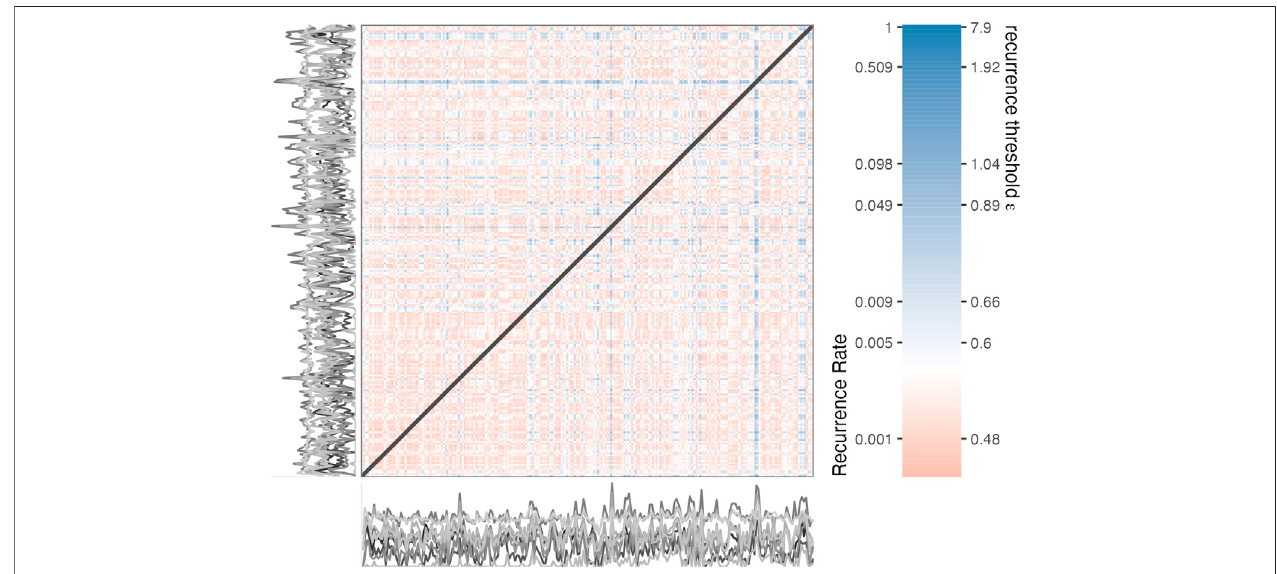
FIGURE 2 | Distance matrix based on 12 time series (displayed as grey lines) representing self-reports of the mood of an individual.